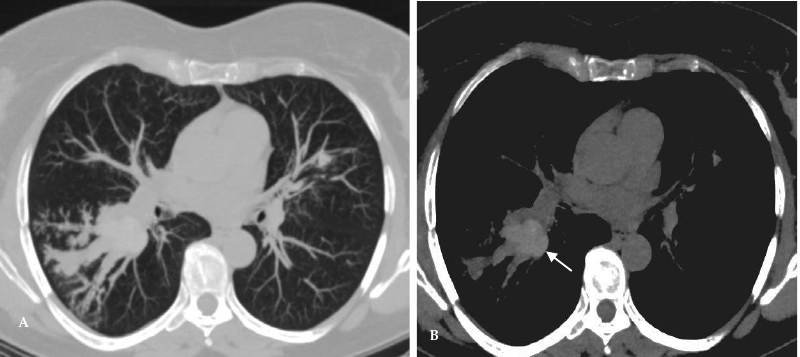
Figure 14. 39-year-old female with ABPA and asthma. ( A ) Axial CT image depicts right lower lobe varicose bronchiectasis with mucoid impaction. ( B ) High-attenuation mucus plugging on CT (arrow): a pathognomonic feature of ABPA.